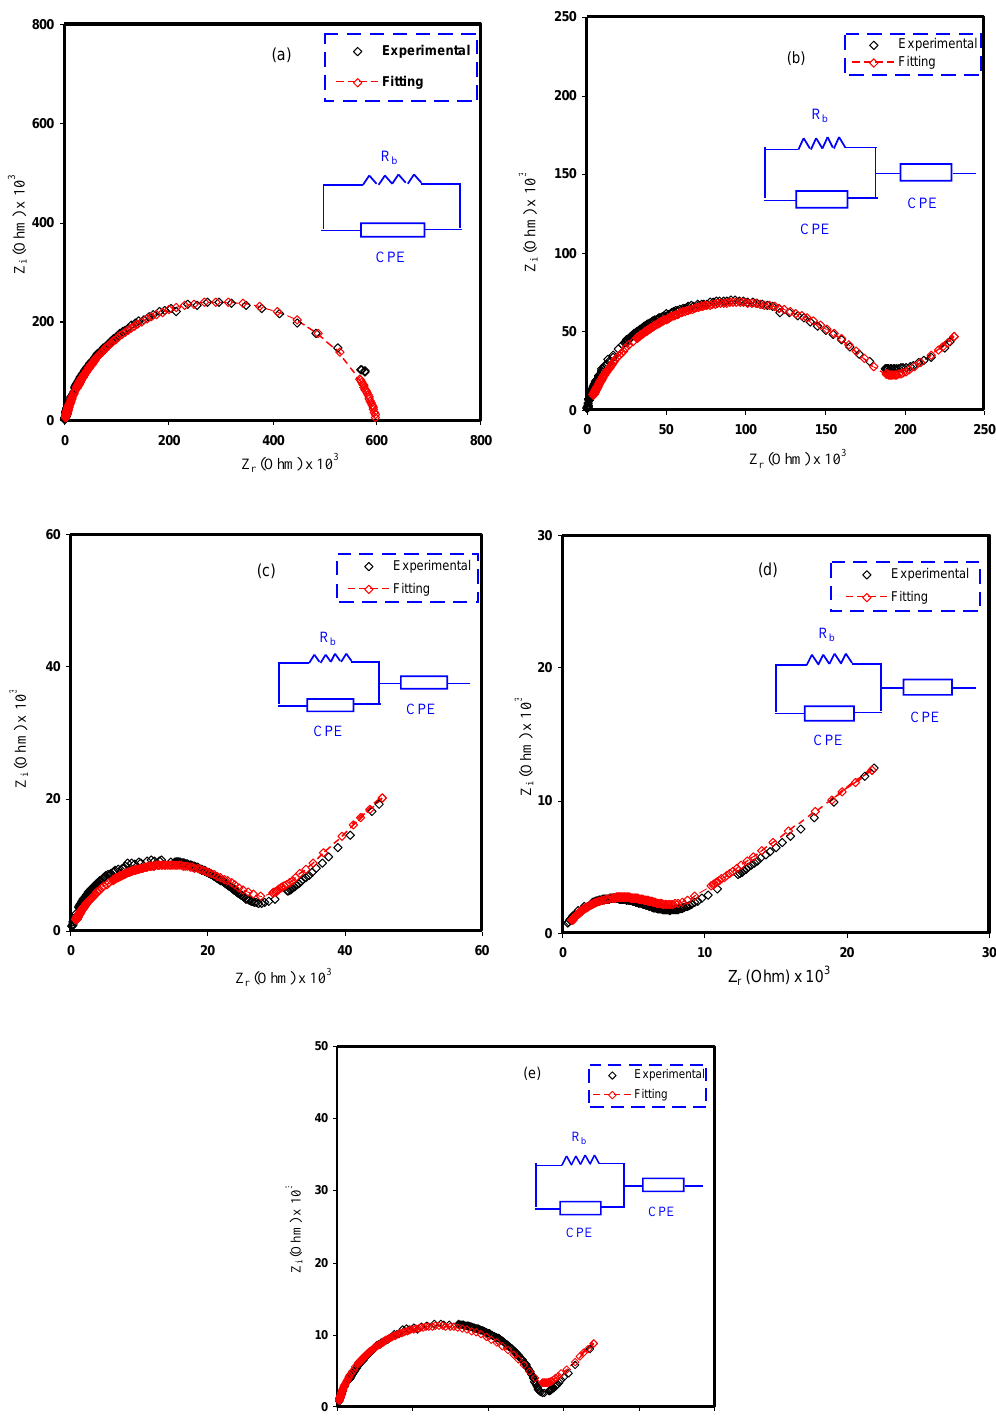
Figure 6. Experimental and EEC fitting plots for ( a ) PVCS 1, ( b ) PVCS 2, ( c ) PVCS 3, ( d ) PVCS 4 and ( e ) PVCS 5.